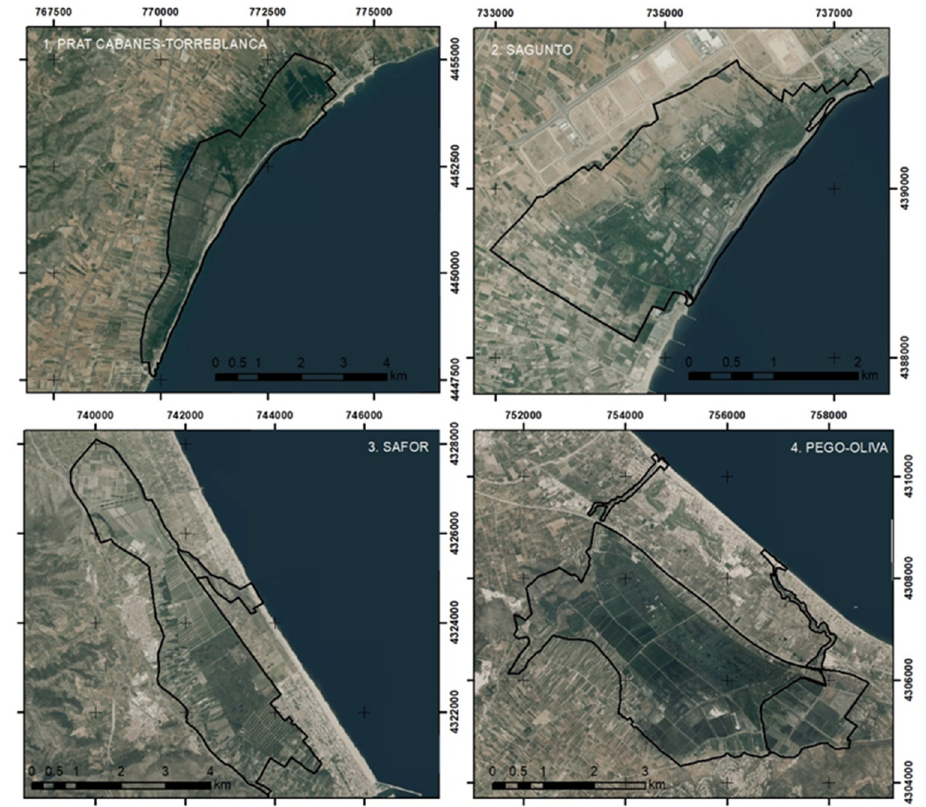
Figure 2. Wetlands area according to the official delimitation of the protected area (Valencian Wetland Inventory). Spatial Reference System: European Terrestrial Reference System 1989, UTM coordinates Zone 30S.